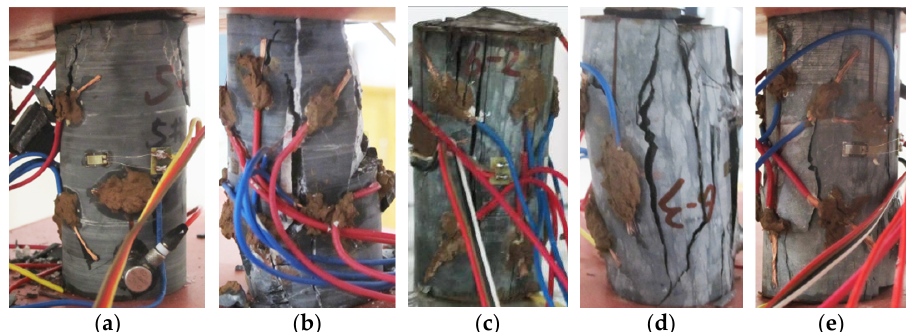
Figure 6. Failure state of rock samples normal to the bedding direction. ( a ) Rock sample 5 ‐ 1; ( b ) Rock sample 5 ‐ 2; ( c ) Rock sample 6 ‐ 2; ( d ) Rock sample 6 ‐ 3; ( e ) Rock sample 6 ‐ 4.